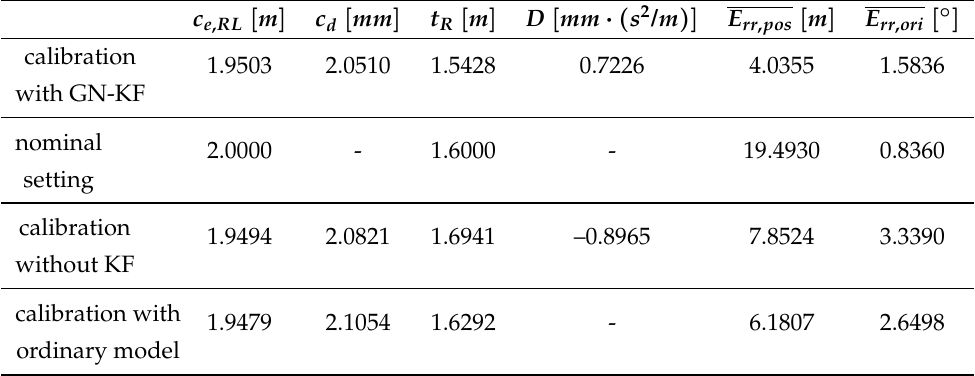
Table 4. Estimated parameters and average test